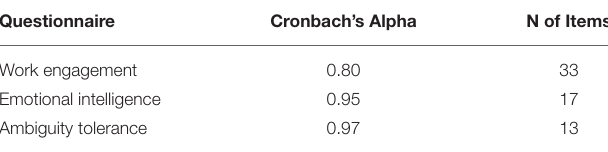
TABLE 1 | Reliability of the